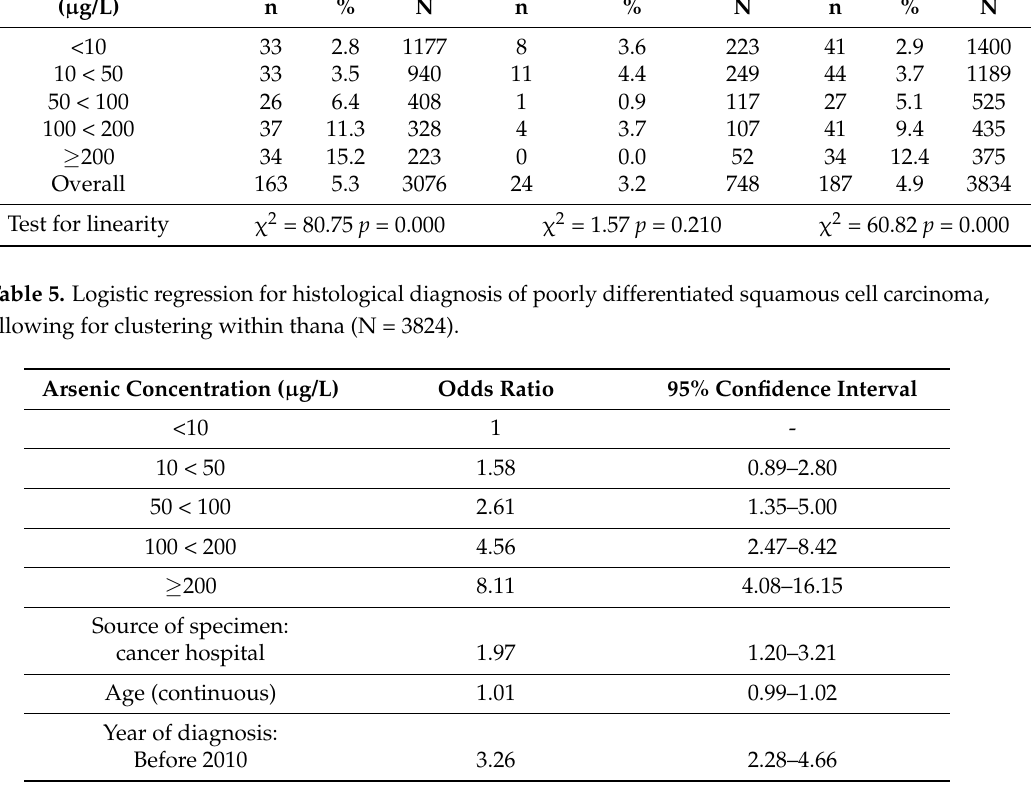
Table 4. Proportion of squamous cell lesions that are poorly differentiated by arsenic concentration. Arsenic Concentration Cancer Hospital